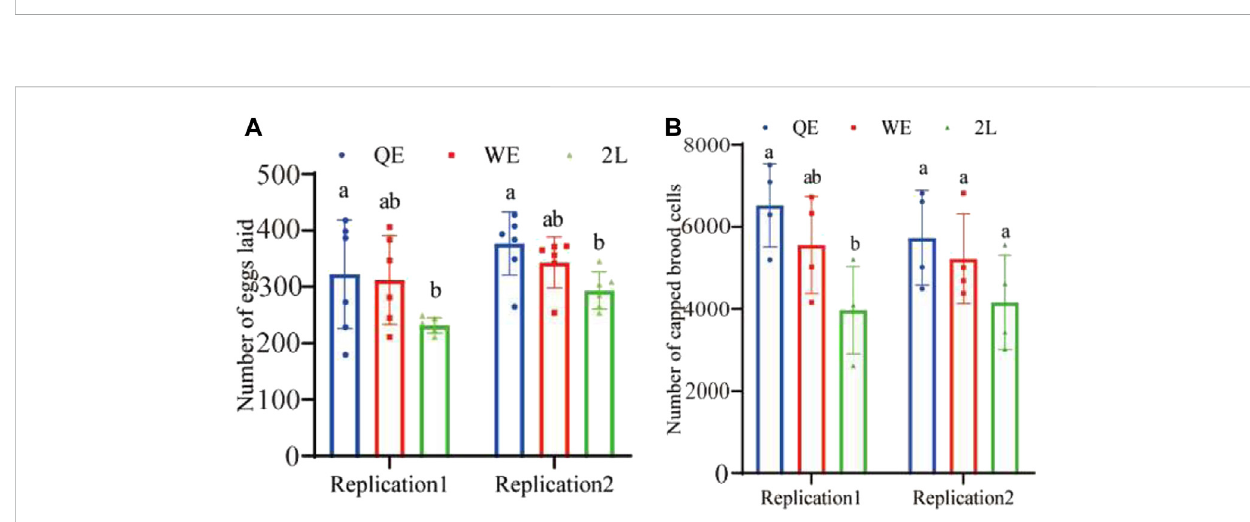
FIGURE 3 (A) Numberofeggslaidbyrearedqueenswithin6 hand (B) numberofcappedbroodcellscountedduringa12-dayperiodineachgroup(numberof eggs laid: n = 6 for QE, WE, 2L in replication 1 and replication 2. Number of capped brood cells: n = 4 for QE, WE, 2L in replication 1 and replication